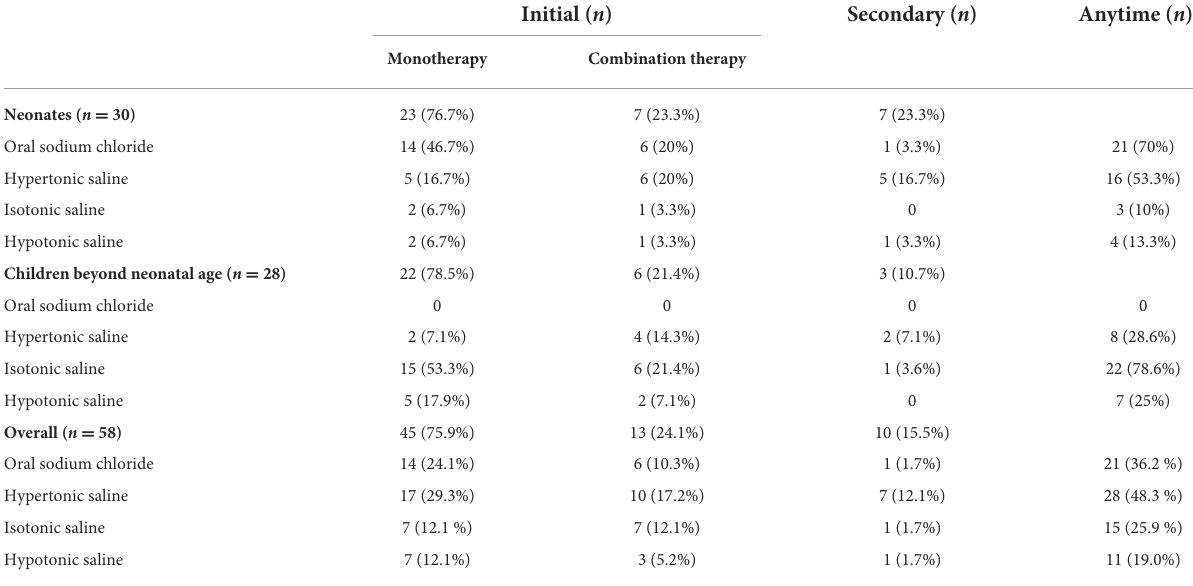
TABLE 2 Sodium-altering therapy employed as first or second-line